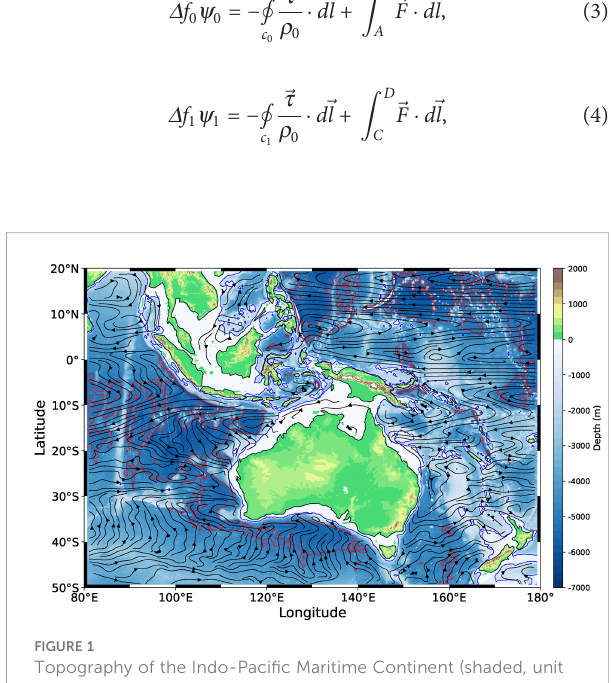
FIGURE 1 Topography of the Indo-Paci fi c Maritime Continent (shaded, unit in m) and mean horizontal currents averaged over the upper 100 m layer from SODA (black streamlines). Blue contour lines denote the 1000 m isobaths, and red contour lines denote the 5000 m